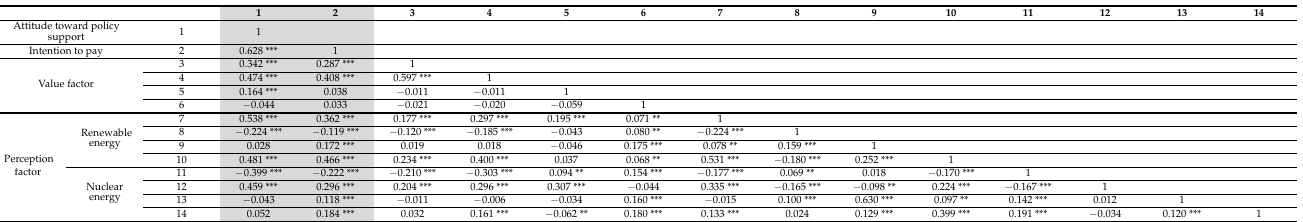
Table 2. Pearson simple